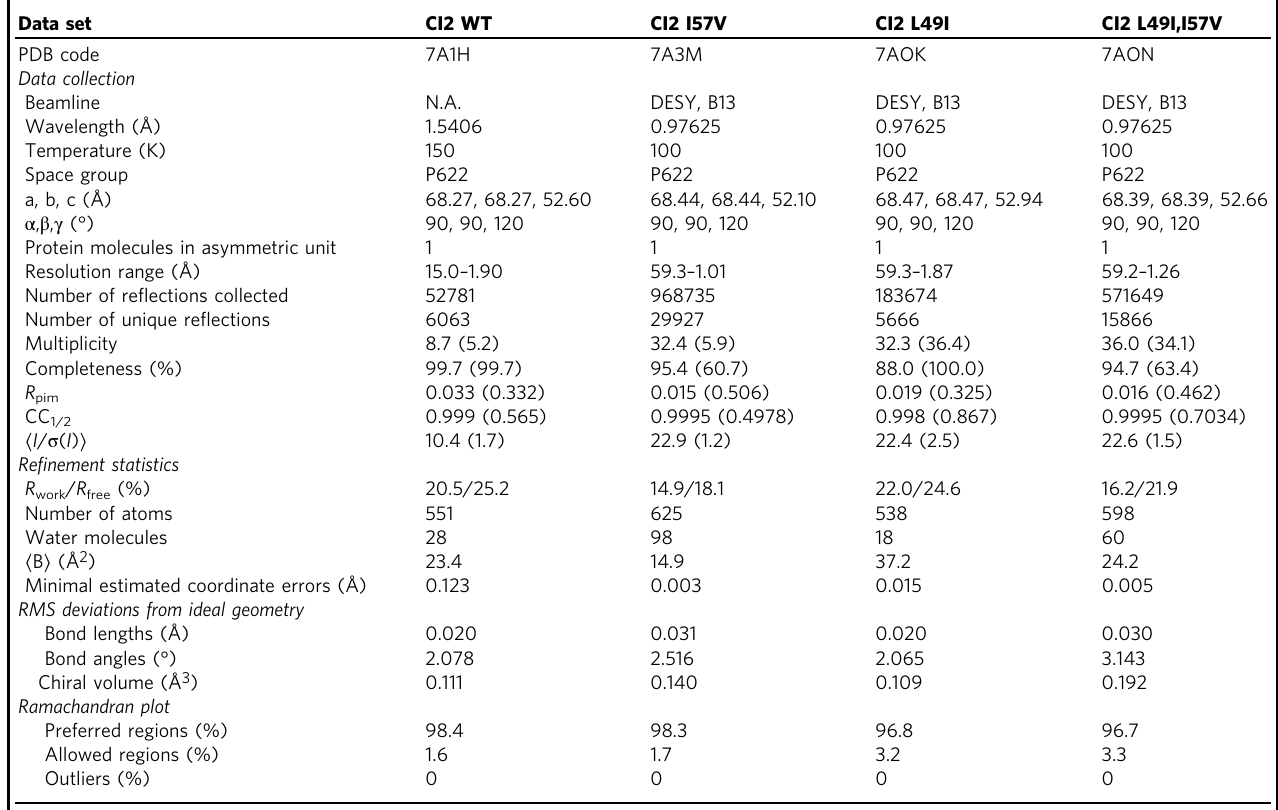
Table 2 Crystallographic